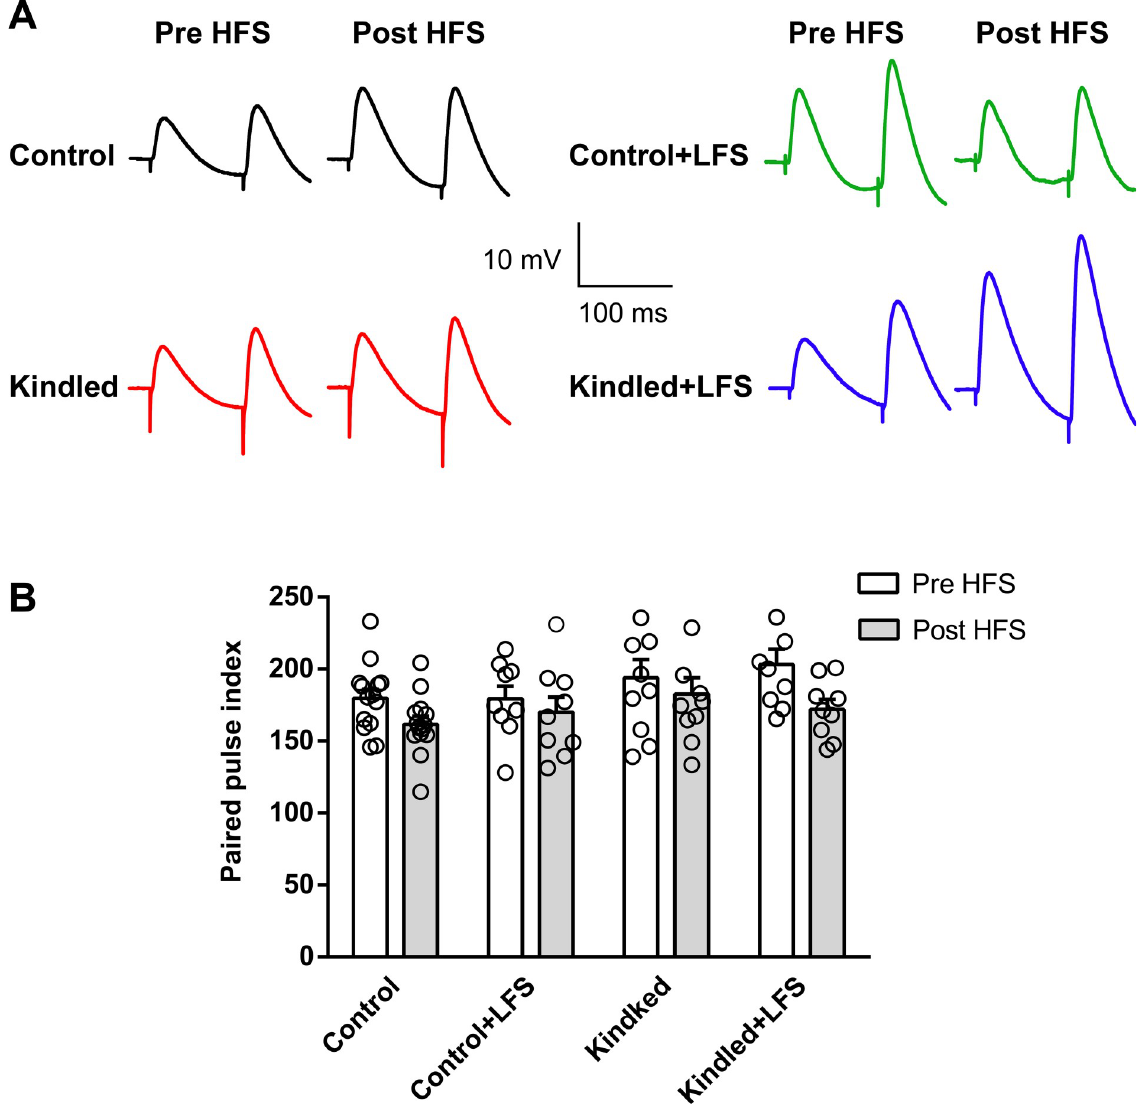
Fig 2. Effect of LFS on PPI of EPSPs before and after HFS application in hippocampal slices of different experimental groups. (A) Sample recording of EPSPs paired pulses in different experimental groups. No significant change in PPI of EPSPs was observed before and after HFS application in the control, control+LFS, kindled or kindled+LFS group. Control: n = 14, Control+LFS: n = 9, Kindled: n = 10, Kindled+LFS: n = 9. Data are shown as mean ±